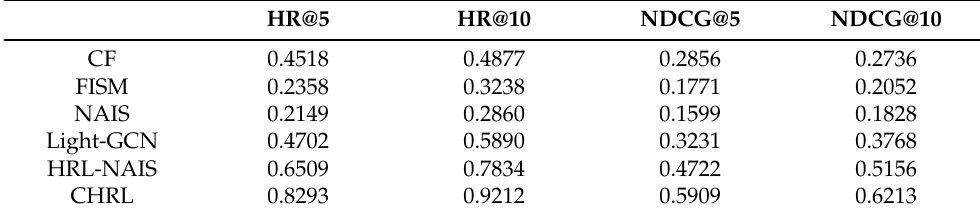
Table 3. Recommendation performance on school borrowing data.